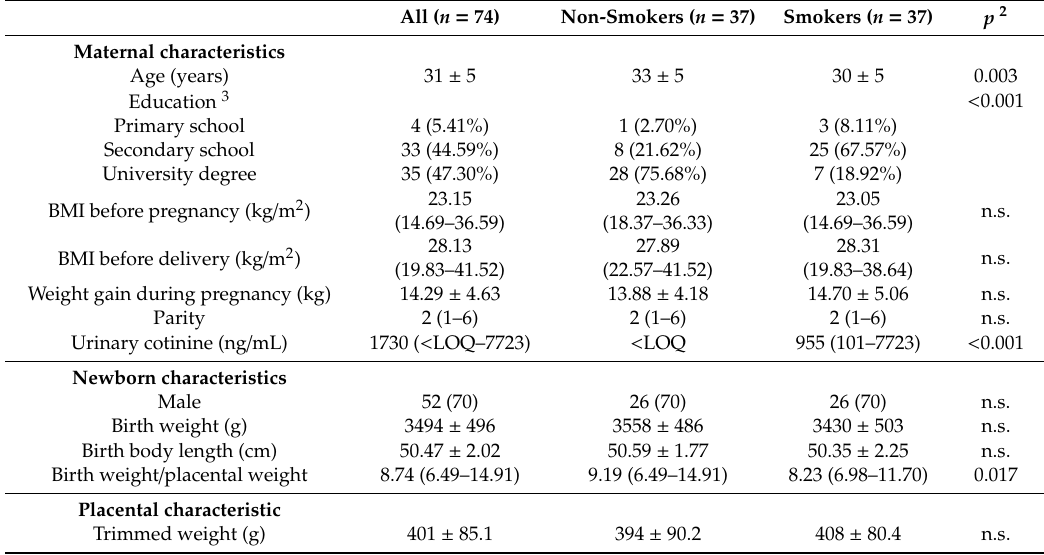
Table 1. General characteristics of postpartum women and their newborns at delivery grouped by maternal smoking habit according to urinary cotinine levels 1